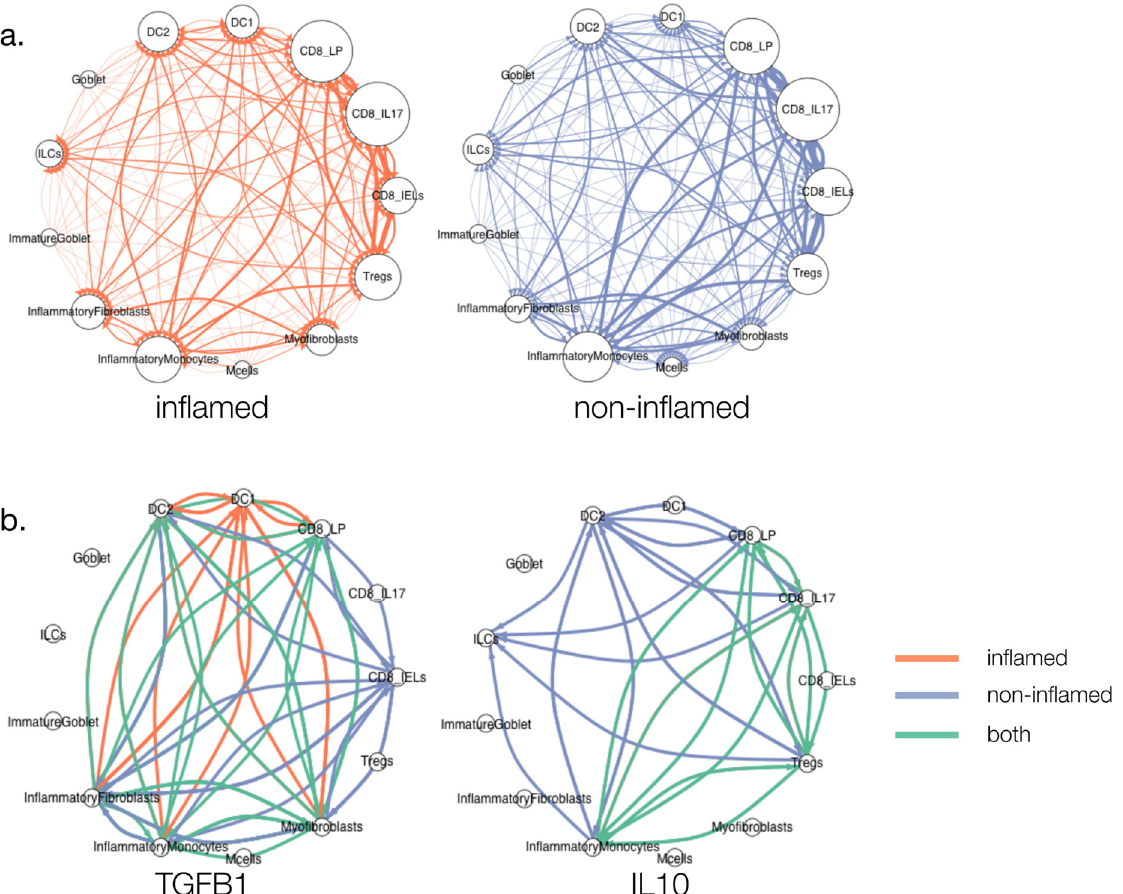
Figure 2. Cytokine-specific rewiring of intercellular interactions in ulcerative colitis. Global cell–cell interaction ( a ) and cytokine-specific cell–cell interaction ( b ) networks in inflamed and non-inflamed UC tissues. ( a ) Global cell–cell interaction networks showed only a few differences in the cell types interacting with each other between non-inflamed and inflamed UC states. More interactions between inflammatory fibroblasts and type 1 dendritic cells (DC1s) were present in inflamed UC compared to non-inflamed UC. The size of the nodes corresponds to the degree. ( b ) Cytokine-specific cell–cell interaction networks revealed more notable differences between non-inflamed and inflamed UC states, particularly with the cytokines IL10 and TFB1. IL10 was found to be produced by regulatory T cells (Tregs) in both inflamed and non-inflamed UC tissues, but in non-inflamed conditions, IL10 was found to interact with additional cell types including innate lymphoid cells (ILCs) and type 2 dendritic cells (DC2s). In inflamed UC, TGFB1 signalling shifted to interactions occurring mostly between DC1s and inflammatory fibroblasts, myofibroblasts, DC2s, and CD8 lamina propria (LP) T cells.